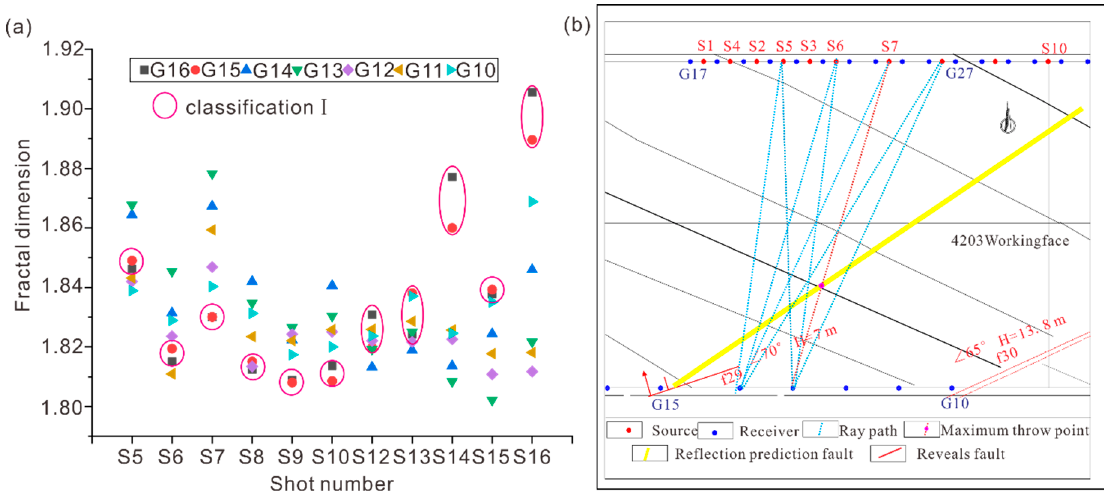
Figure 10. ( a ) Fractional dimension matrix; ( b ) maximum throw